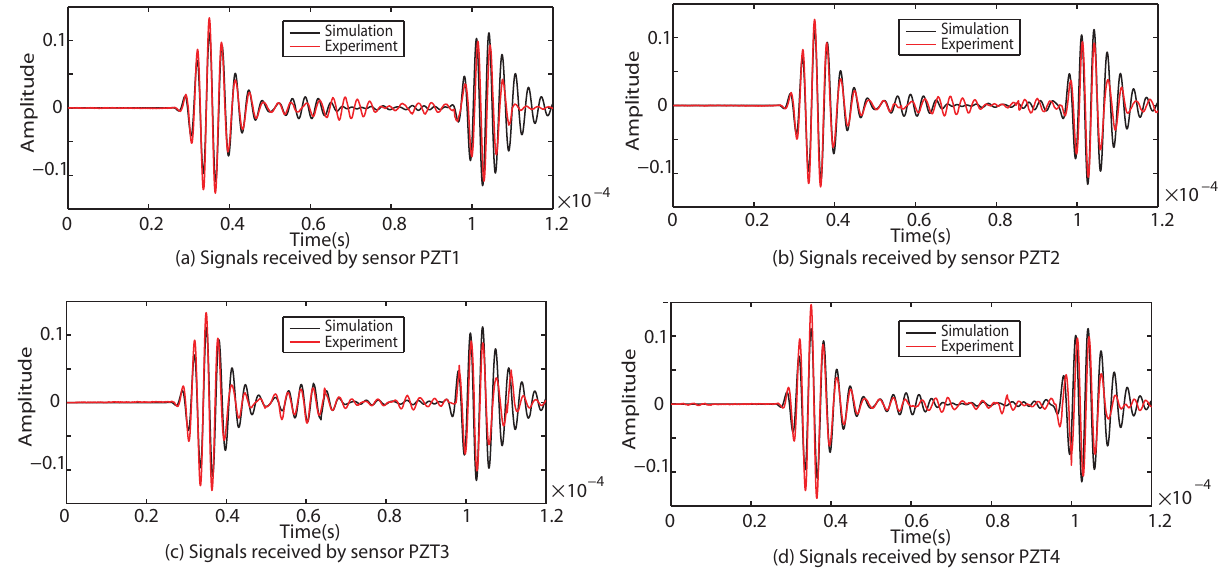
Figure 11. Comparison of experimental and simulation results under Case